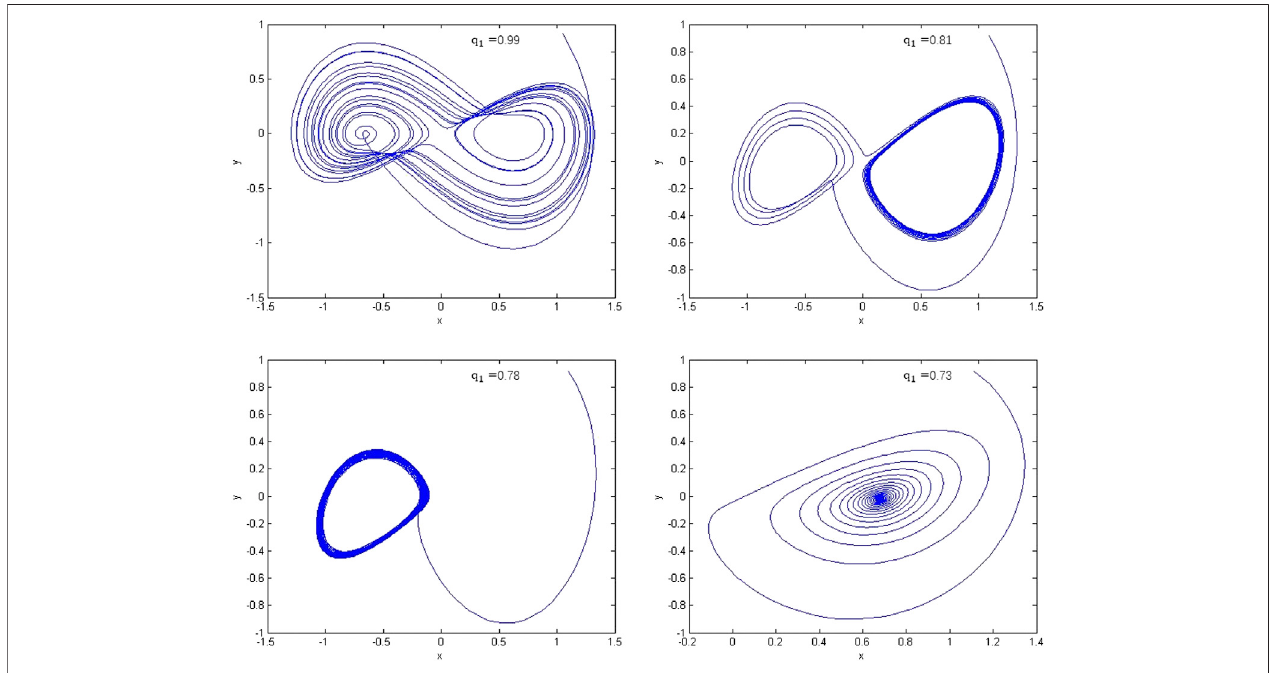
FIGURE 4 | Phase portraits of model Eq. 2.9 with q 1 (cid:1) q 2 (cid:1) 1.